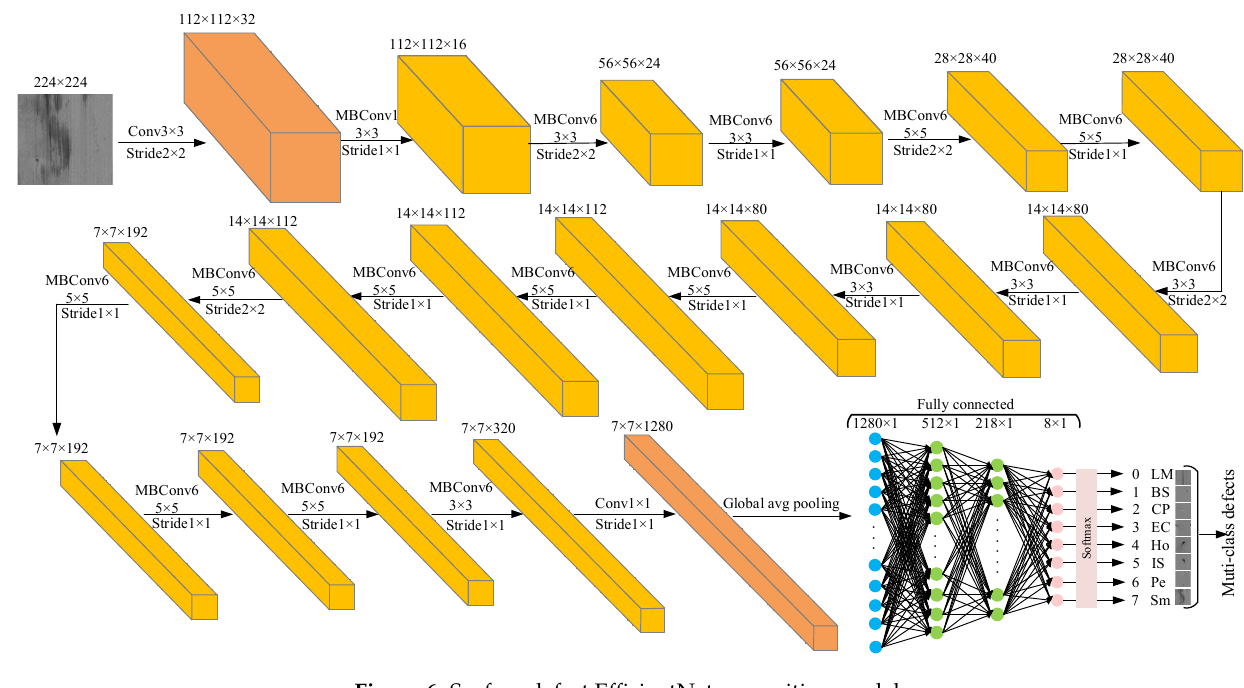
Figure 6. Surface defect EfficientNet recognition model.